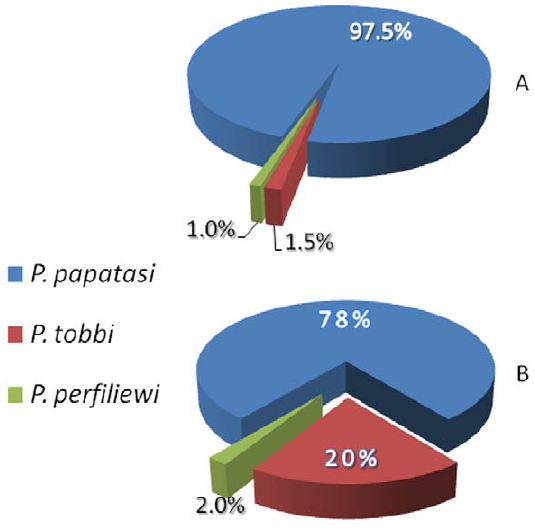
Figure 3. The species composition of phlebotomine sand flies captured using CO 2 baited traps. A – Sample of sand flies trapped near the houses (n=385) comprising 97.5% P. papatasi . B – Sample of sand flies trapped in an alfalfa field (n=250) 1 km south of Kibbutz fence.